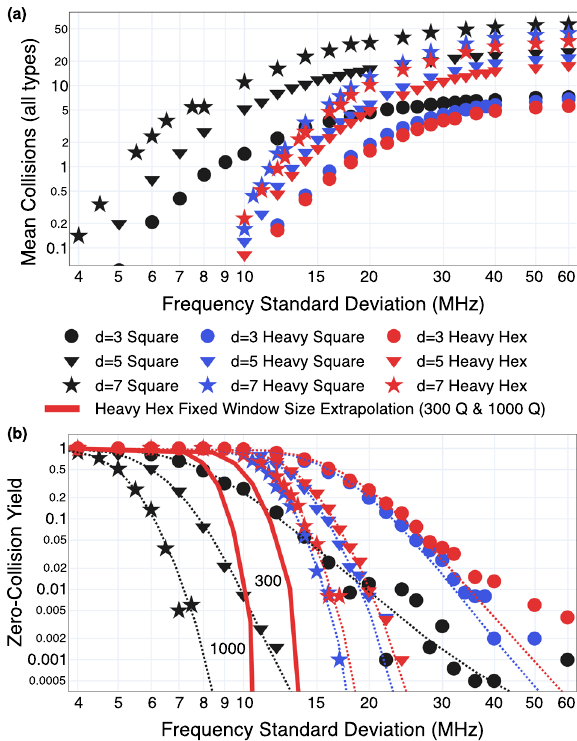
Fig. 4 Frequency-crowding trends as a function of σ f . Results of Monte Carlo simulation (see “ Methods ” ). Simulation was applied to the lattices and frequency patterns shown in Fig. 3, capable of distance-5 codes, as well as to d = 3 and d = 7 scale lattices of square, heavy-square, or heavy-hexagon type (See Supplementary Figs. 1 – 9 for lattice layouts and Table 2 for numbers of qubits.). a Average number of collisions. b Fraction of cases having zero frequency collisions. Color-coded dotted lines are fi ts of each lattice R ð Δ f = σ f Þ yield to expression (cid:2)1 yield for the heavy-hexagon lattice type at 300 and 1000 qubits, using Δ f = 27.99 and 26.32 MHz, respectively. See Fig. 5 for estimation of Δ f as a function of qubit